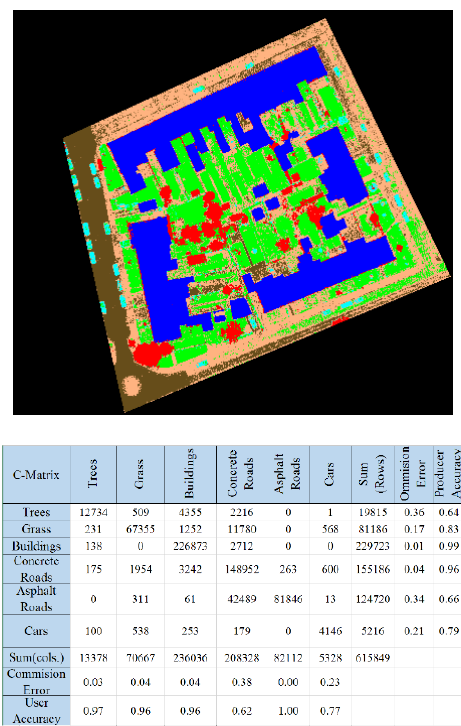
Figure 7. Obtained results from Bayesian classifiers based on merely LiDAR feature